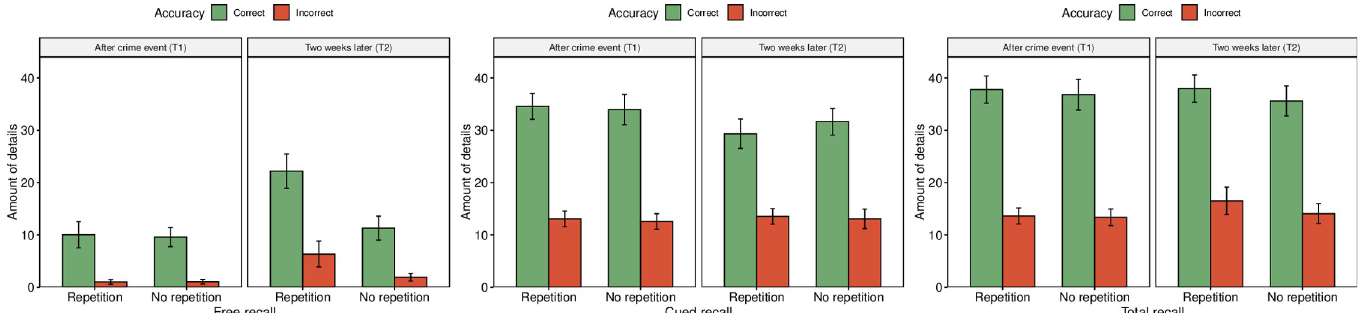
Fig 1. Mean number of unique correct and incorrect details recalled across time and repetition. Note. Error bars represent 95% confidence intervals.